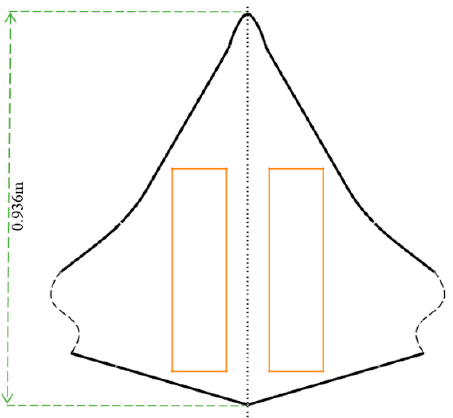
Figure 1. Geometric outline of the blended wing body (BWB) aircraft model used in the current research.